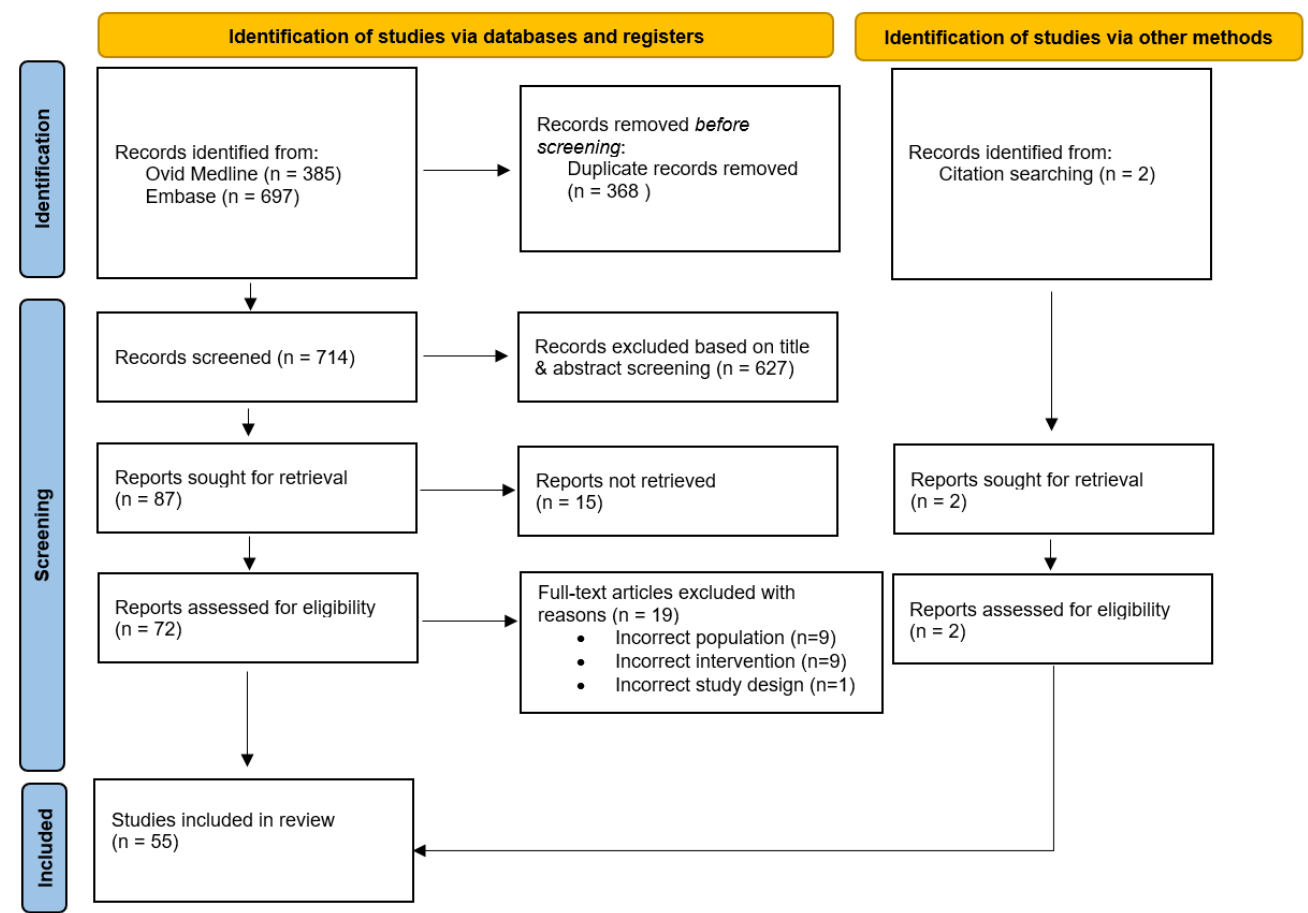
Figure 1. PRISMA diagram detailing study selection process.